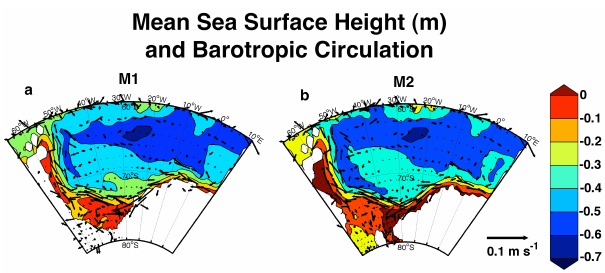
Fig. 7. Annual mean sea surface height in meters and barotropic circulation in the Weddell Sea for M1 (a) and M2 (b) experiments.